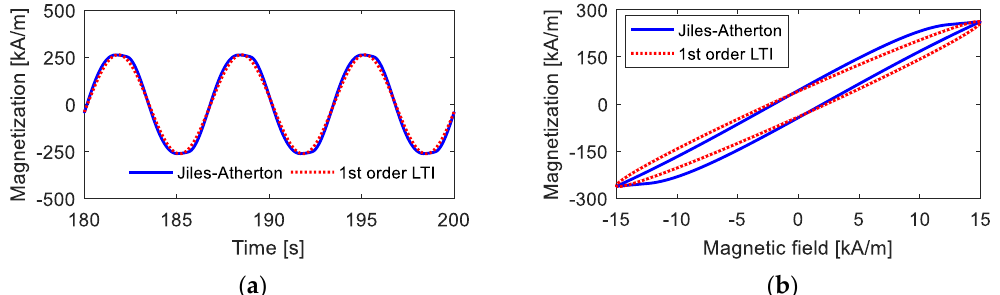
Figure 5. Magnetization curves under low magnetic field intensity calculated from the Jiles – Atherton model and the 1st − order LTI system model: ( a ) time − domain curves; ( b ) M − H curves.